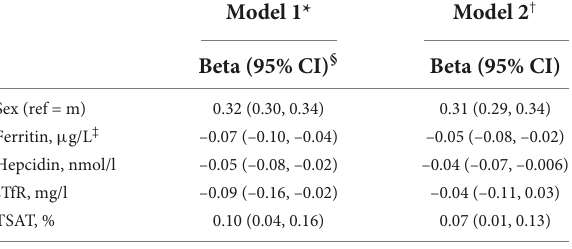
TABLE 2 Association of sex and iron biomarkers with